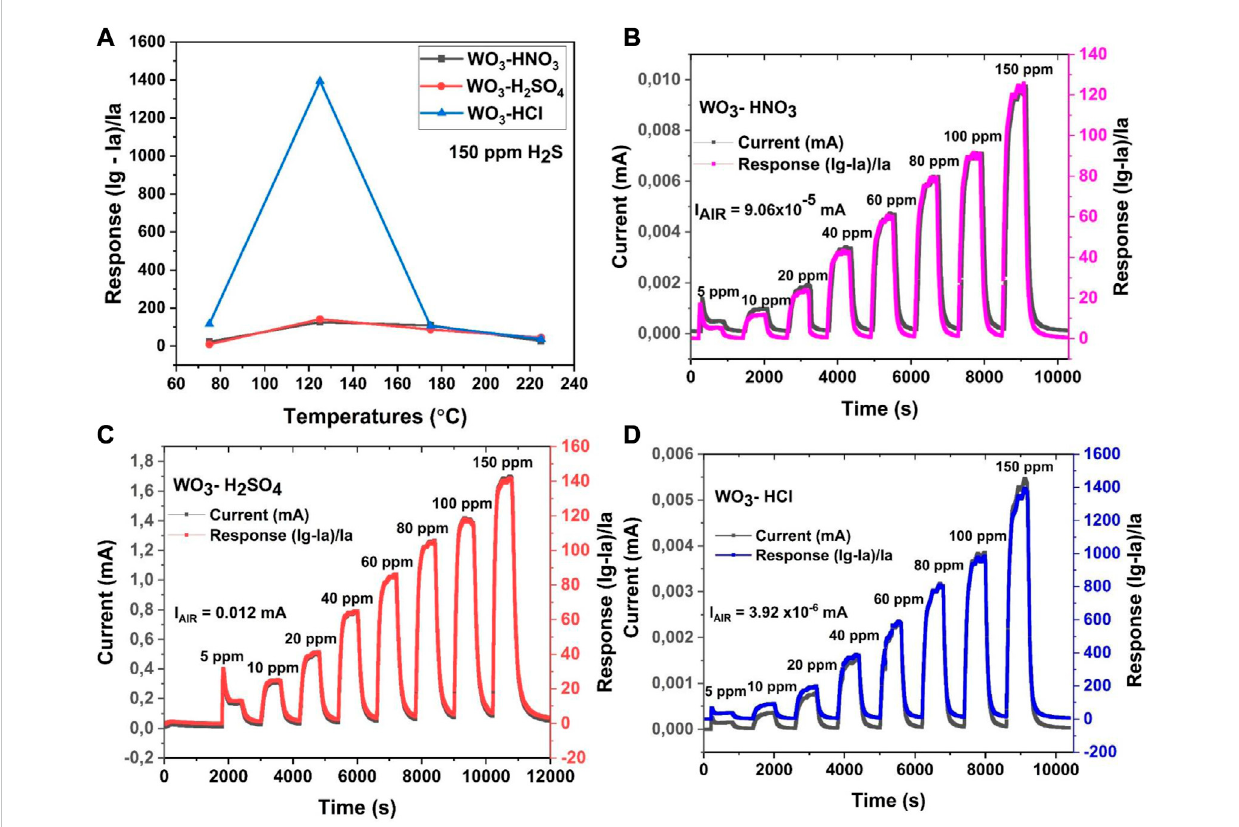
FIGURE 9 (A) Operating-temperature dependence response of WO 3 samples towards 150 ppm of H 2 S, and (B – D) The dynamic response curves of: (B) WO 3 - HNO